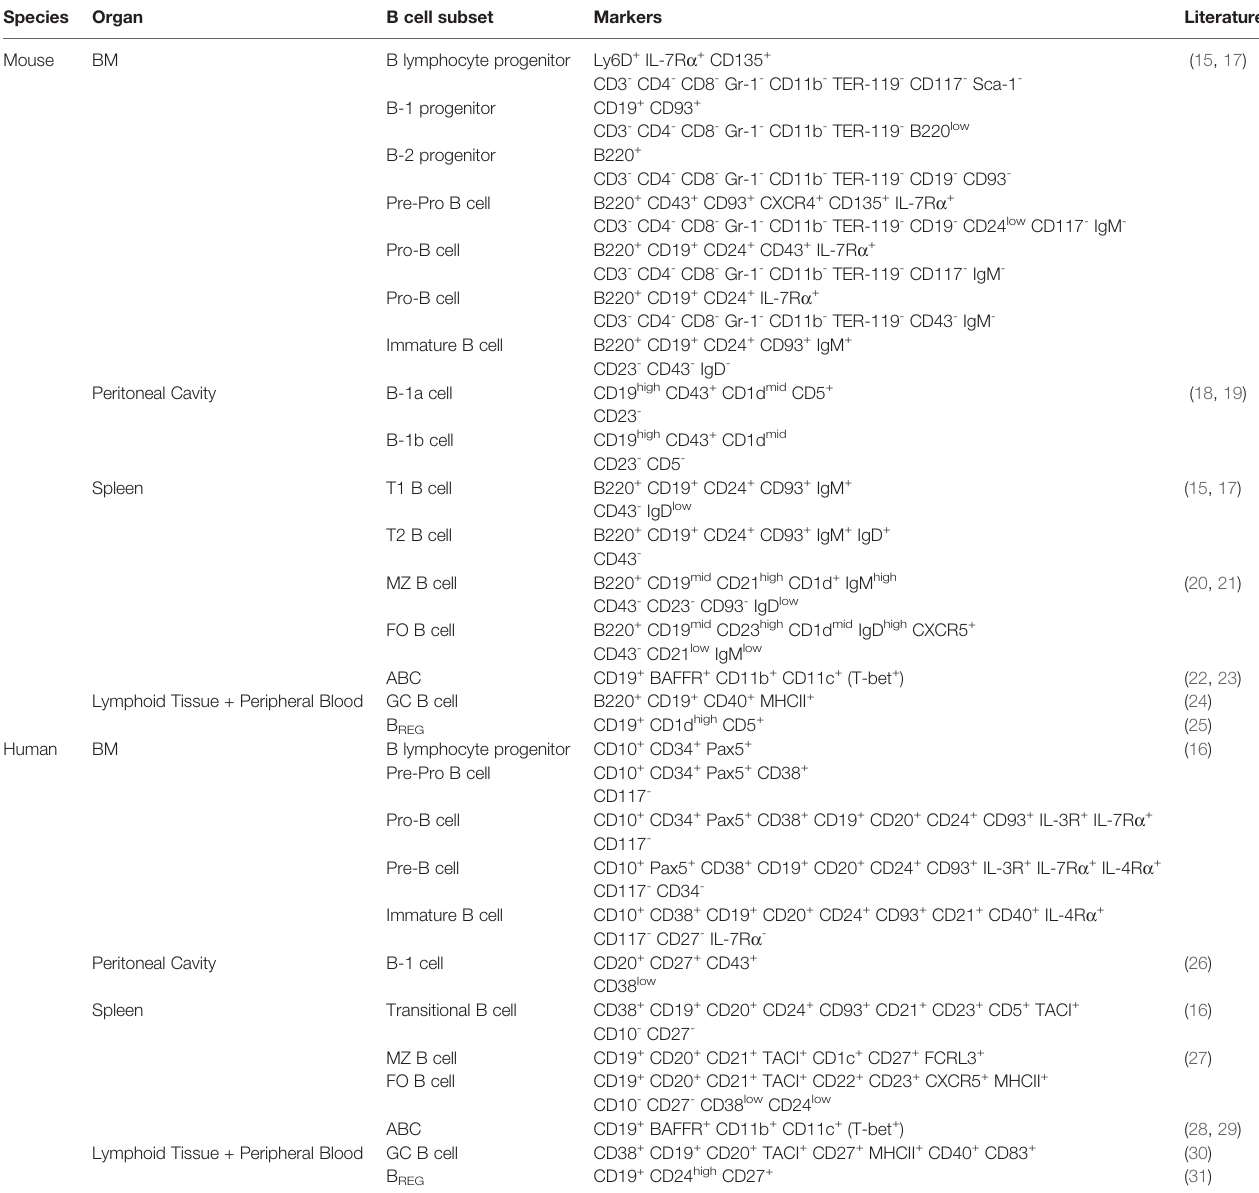
TABLE 1 | Phenotype of distinct B cell subsets in mice and humans. Species Organ B cell subset Markers